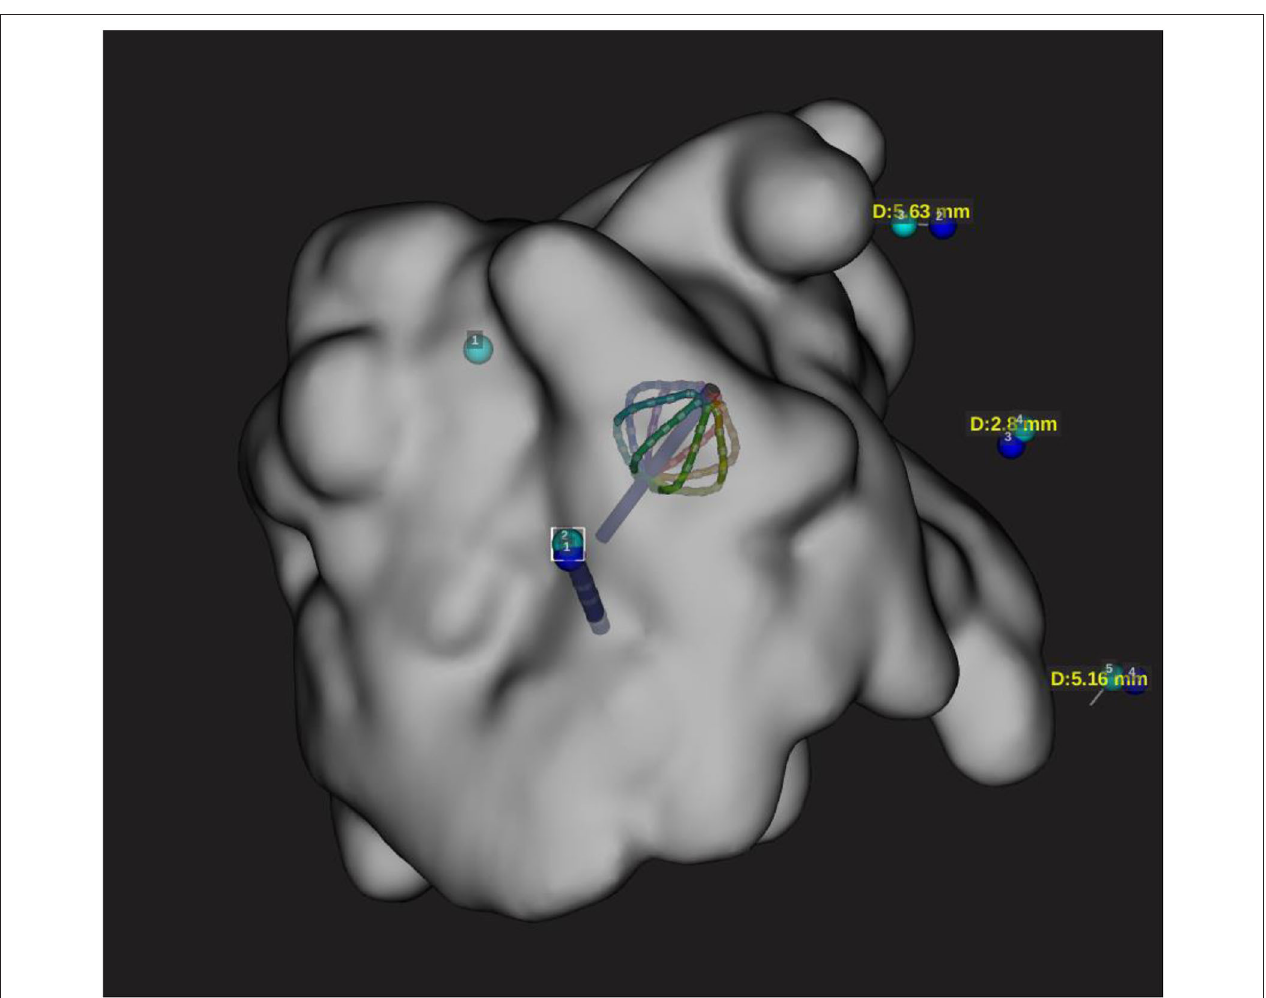
FIGURE 5 | Configuration 3.2 during RF delivery. Localization accuracy of DTA catheter on the EAM during RF application (50w 30s). This configuration has shown no catheter shift during RF application.